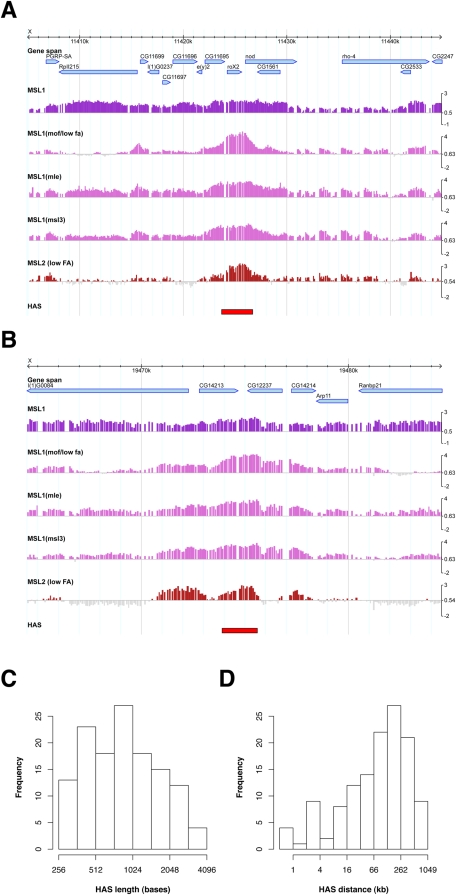
The new set of 131 X-chromosomal sites contain all established high-affinity sites of the Drosophila DCC.A) rox2 and B) the site at 18D displayed with MSL1 wild type and residual profiles after RNAi and/or low formaldehyde crosslinking. Histograms of the length distribution (C) and distance distribution (D) between high-affinity sites (histograms were calculated on log-transformed values).